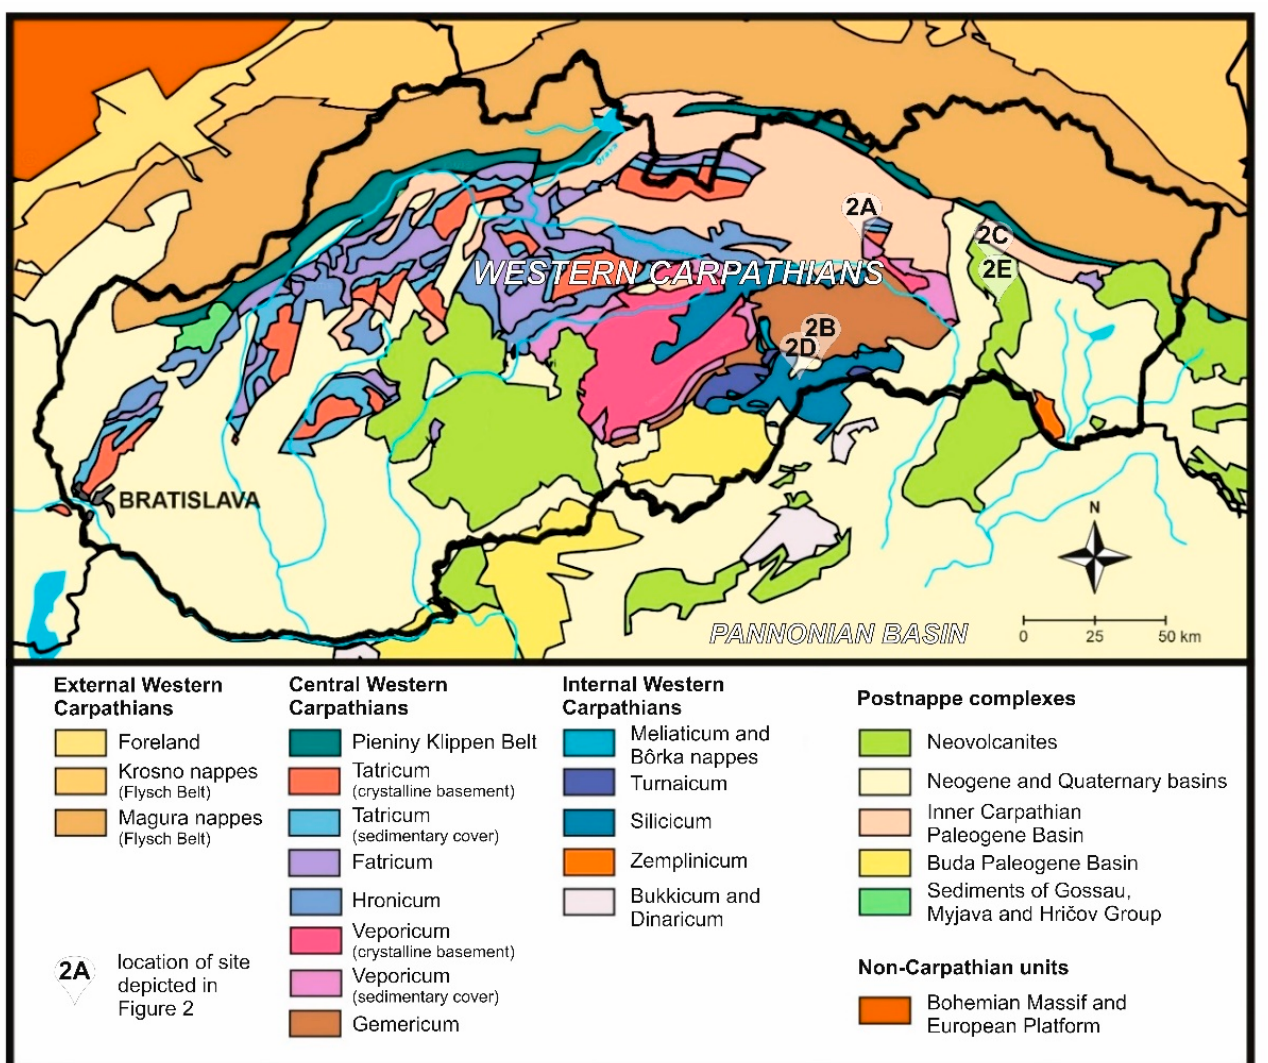
Figure 1. Geological map of Slovakia [39,40].